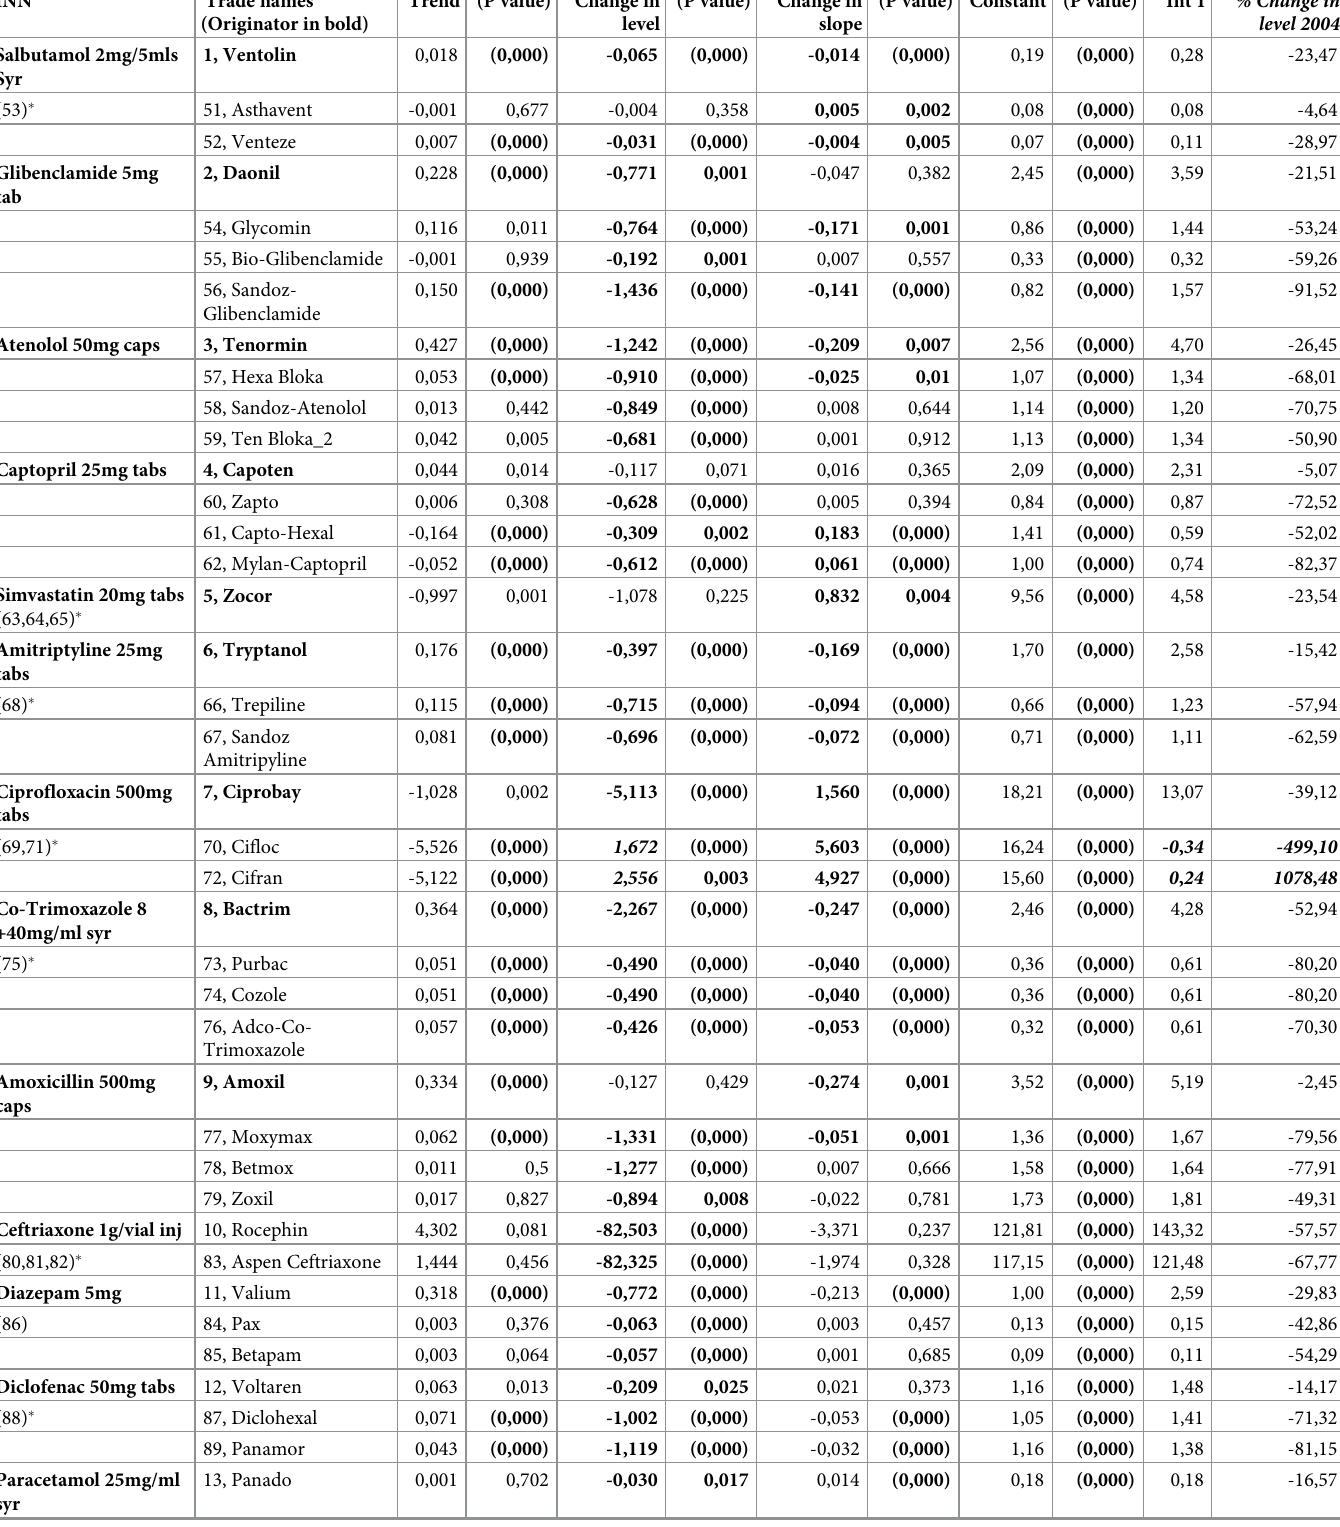
Table 1. Global core interrupted time-series analysis for originator and generic molecules using pricing data from 1999 to 2014 with 2004 as the interruption in the series (P < 0,05).